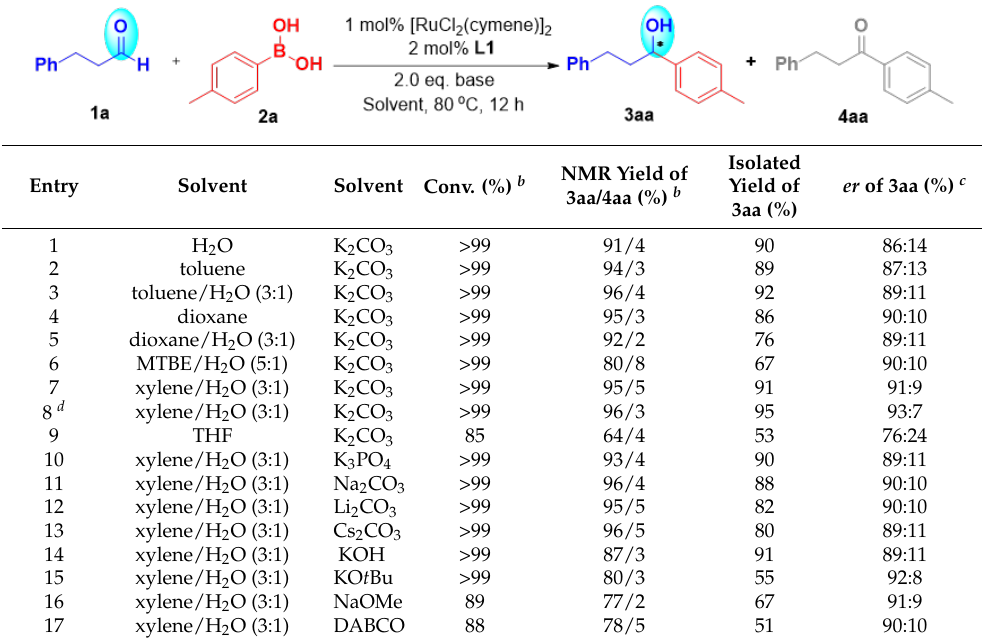
Table 2. Optimization of reaction conditions a .